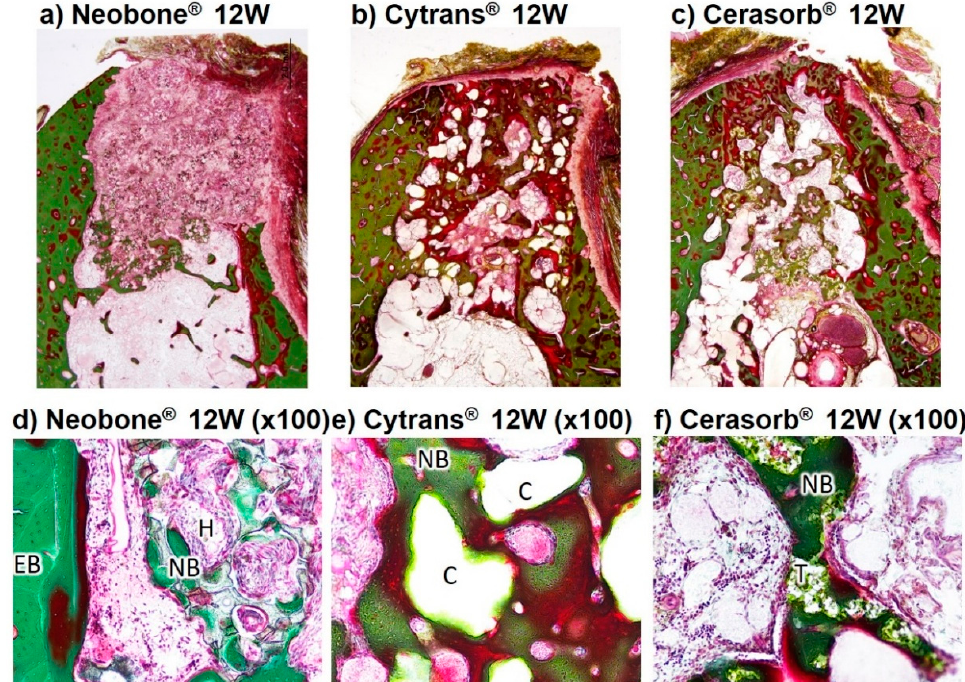
Figure 7. Histological findings of Neobone ® (HAp), Cytrans ® (CO 3 Ap), and Cerasorb ® implanted into dog mandibular bone defect at 12 weeks after implantation (Villanueva Goldner staining). Green area, bone; red area, osteoid. EB, existing bone; NB, new bone; O, osteoid; H, HAp (Neobone ® ); C, CO 3 Ap (Cytrans ® ); T, β -TCP (Cerasorb ® ).